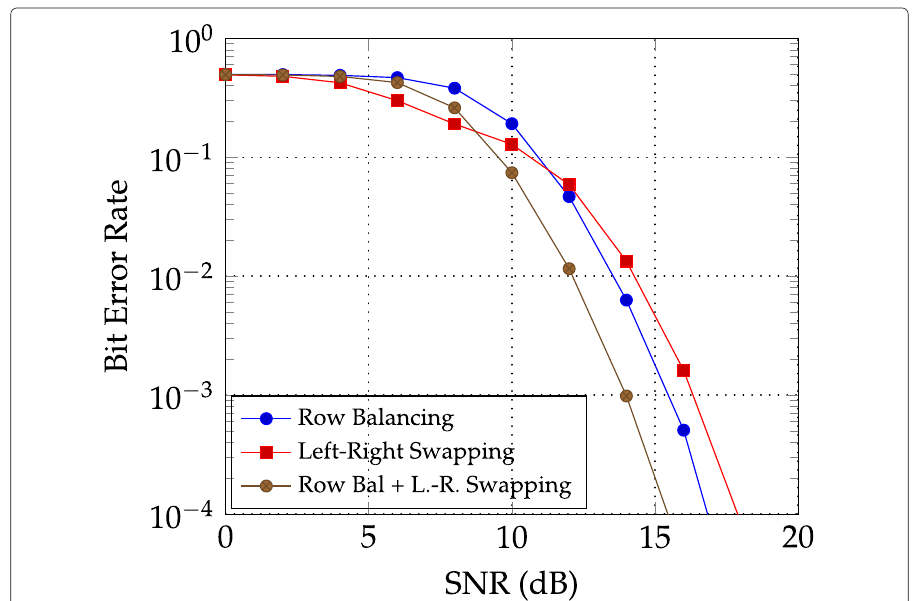
Fig. 9 BER performance in MIMO 4 × 4 by combining “row balancing” and “left-right swapping” methods